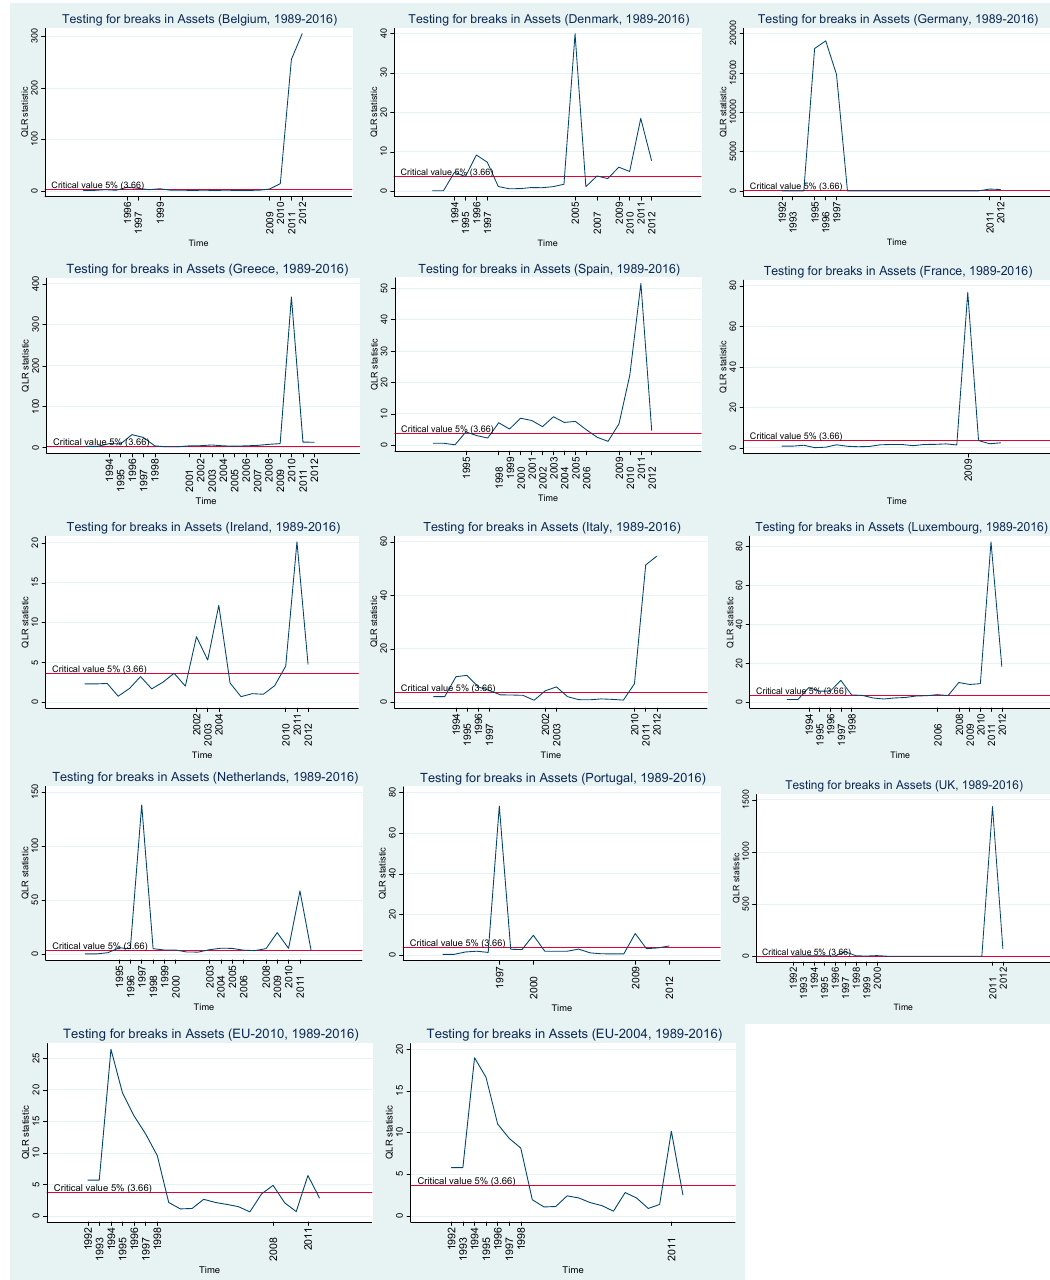
Figure 9. Testing for breaks in total assets (euros) over the European Union countries (1989–2016).